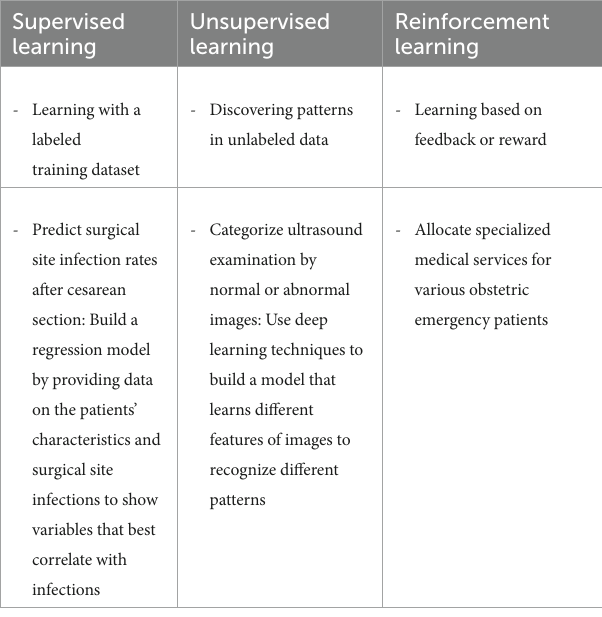
TABLE 1 The three main machine learning techniques.